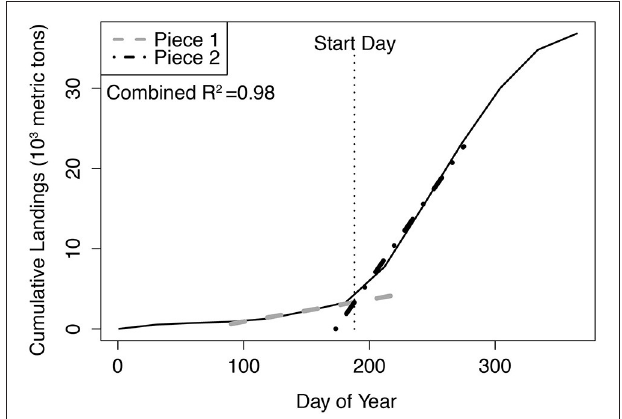
FIGURE 2 | Cumulative landings (10 3 metric tons) in 2009, demonstrating the piecewise regression method for defining start day. Landings data between day-of-year 90 and day-of-year 275 are split into two pieces. These are fitted by simple linear regression, shown by the gray and black dashed lines, and their intersection defines the start day, shown by the vertical dotted line. Landings in 2009 would indicate a start day on day-of-year 188 (July